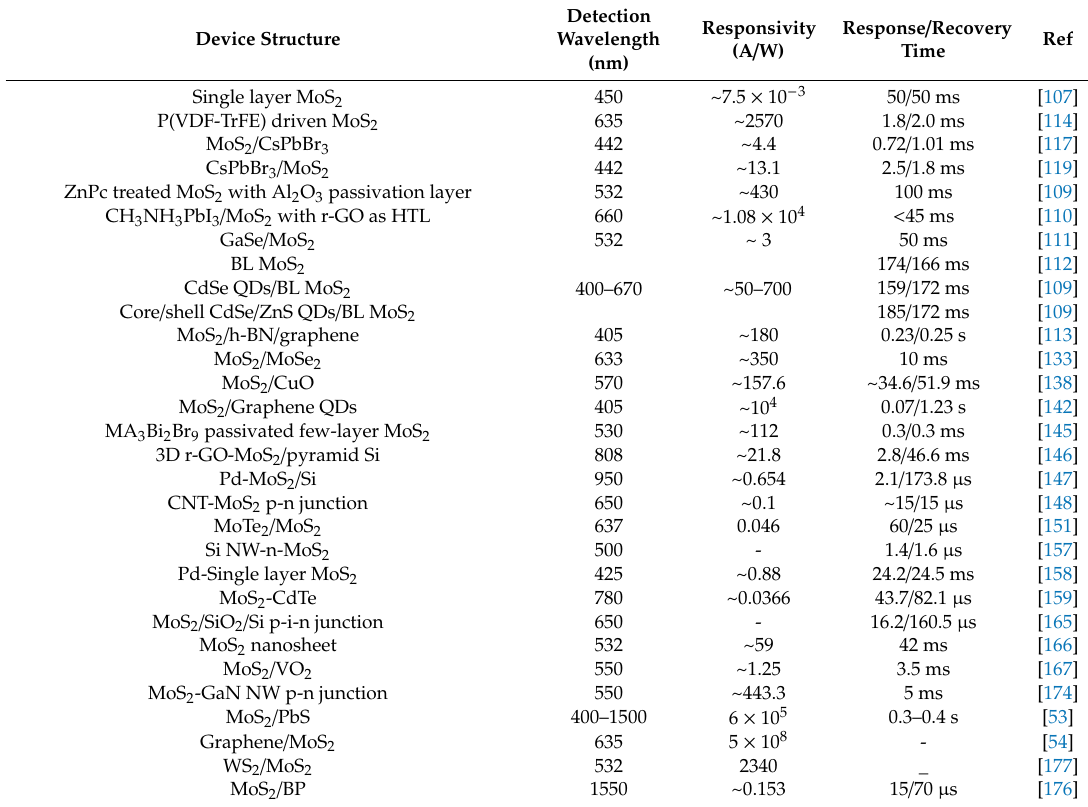
Table 2. Wavelength range, responsivity, response / recovery speed of MoS 2 on SiO 2 / Si substrate and its related